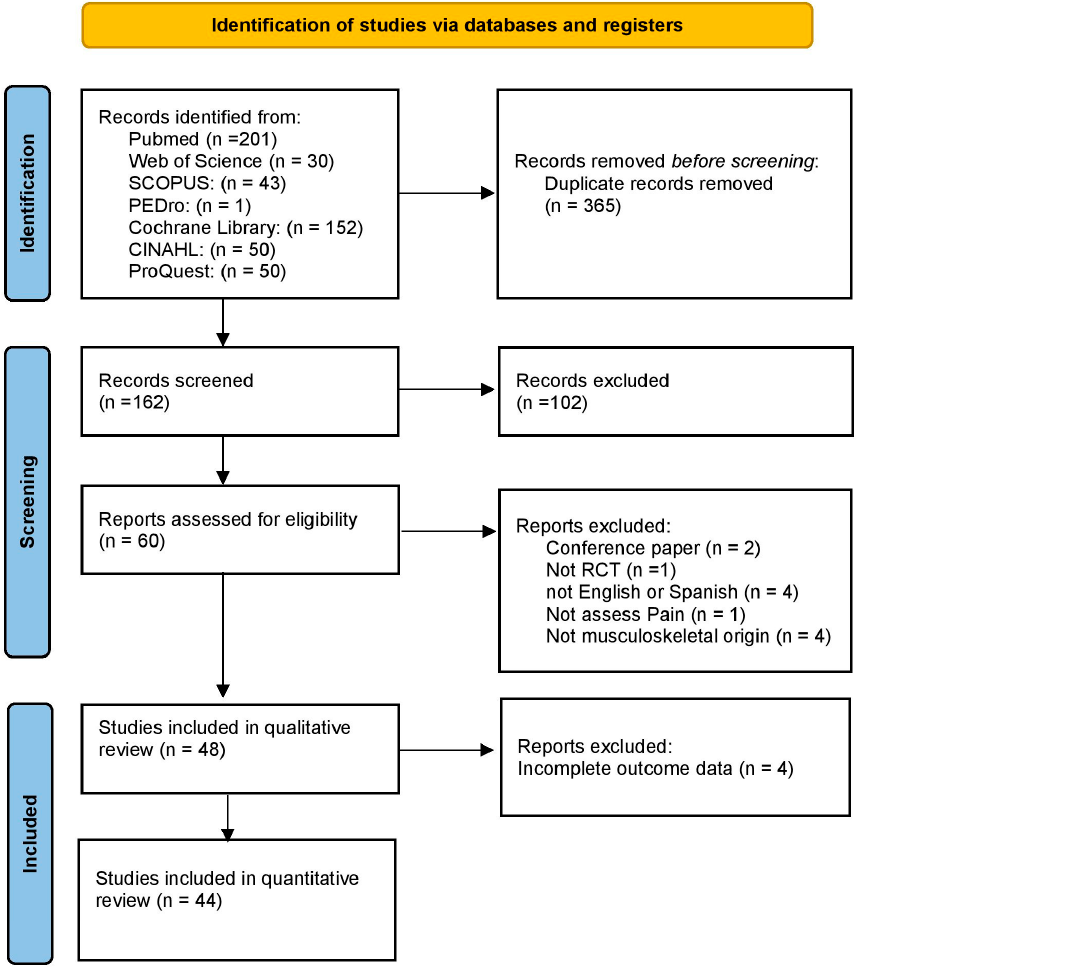
Figure 1. Flowchart of the systematic review and meta-analysis .